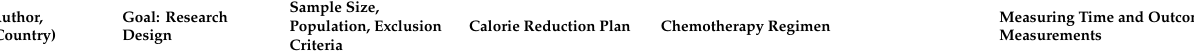
E ff ects on side e ff ects, symptoms, and QOL: not significant - E ff ects on endocrine parameters * and inflammatory response: lower IGF-1 - E ff ects on DNA damage in healthy cells *: protect and promote recovery - Pathological response *: better pCR